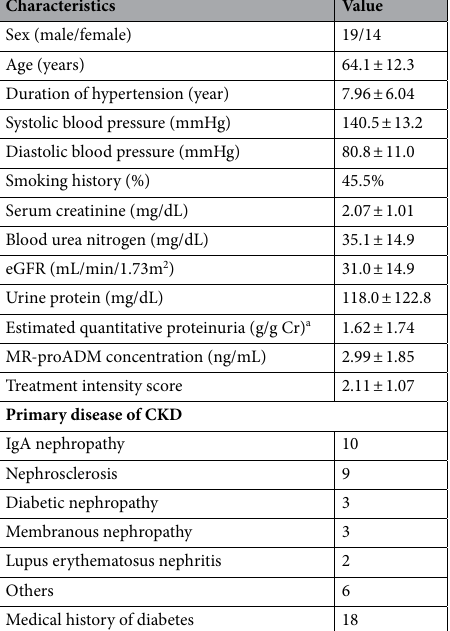
Table 1. Baseline characteristics . eGFR estimated glomerular filtration rate, Cr creatinine, MR-proADM mid- regional pro-adrenomedullin, CKD chronic kidney disease. a Estimated quantitative proteinuria was calculated as urine protein to creatinine